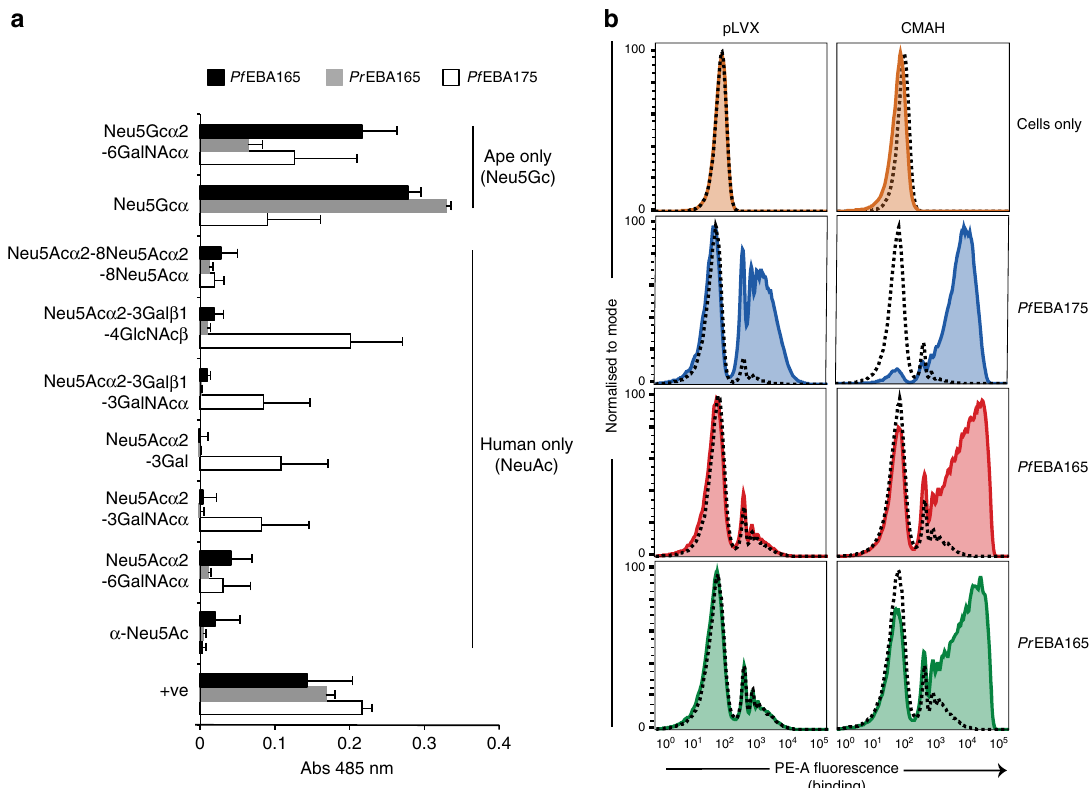
Fig. 3 PfEBA165 and PrEBA165 binding is speci fi c for ape sialic acids. a PfEBA165 and PrEBA165 bind ape, but not human, sialic acids. Puri fi ed mono- biotinylated glycans (GlycoTech) were immobilised on streptavidin-coated 96-well plates, and probed with normalised recombinant pentameric β - lactamase-tagged PfEBA165, PrEBA165 and PfEBA175 (red, green and blue bars, respectively). Binding was detected by incubation with nitroce fi n, a substrate for β -lactamase. The full range of glycans probed are shown in Supplementary Fig. 2; only glycans containing sialic acids are shown here. PfEBA175 was able to bind to glycans containing both Neu5Ac and Neu5Gc, whereas PfEBA165 and PrEBA165 bound only to Neu5Gc containing glycans, which are speci fi c for ape cells. Data points represent mean values of three technical replicates, conducted on the same batches of recombinant proteins and glycans. Error bars represent standard deviation. + ve = positive control, Ox68-bio. Source Data are provided as a Source Data File. b Erythrocyte binding assay using cRBCs incubated with PfEBA165, PrEBA165 and PfEBA175. Solid coloured lines show traces after binding to untreated cRBCs, indicating PfEBA175 binds to both cRBCs produced from both control and CMAH transfected hSCs. PfEBA165 and PrEBA165 bind only to cRBCs produced from CMAH transfected hSCs. In all cases, binding is removed by neuraminidase treatment (dashed lines), which removes extracellular sialic acids. Binding assays were repeated with two biological replicates of cRBCs and recombinant proteins from the same batch. Individual assays included three technical replicates for each condition tested; a single representative technical replicate is